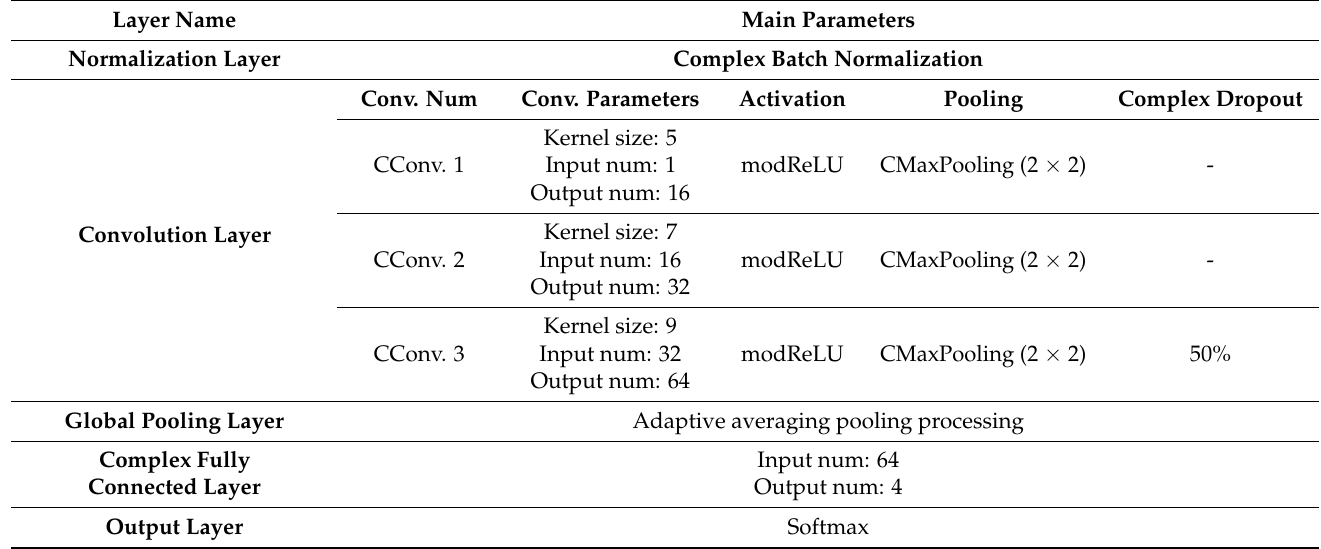
Table 3. The structure and parameter settings of